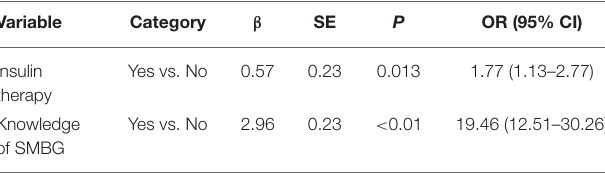
TABLE 2 | Stepwise logistic regression analysis on factors affecting the purchase of blood glucose meters by diabetic